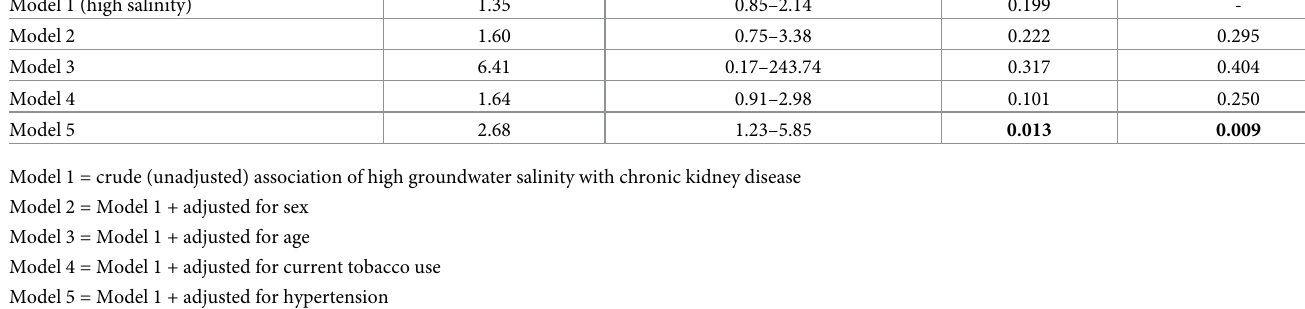
Table 3. Crude and adjusted odds ratios of CKD by high groundwater salinity and interactions with other potential covariates (total n = 356; non-exposed 205; and exposed 151). Crude and unadjusted models